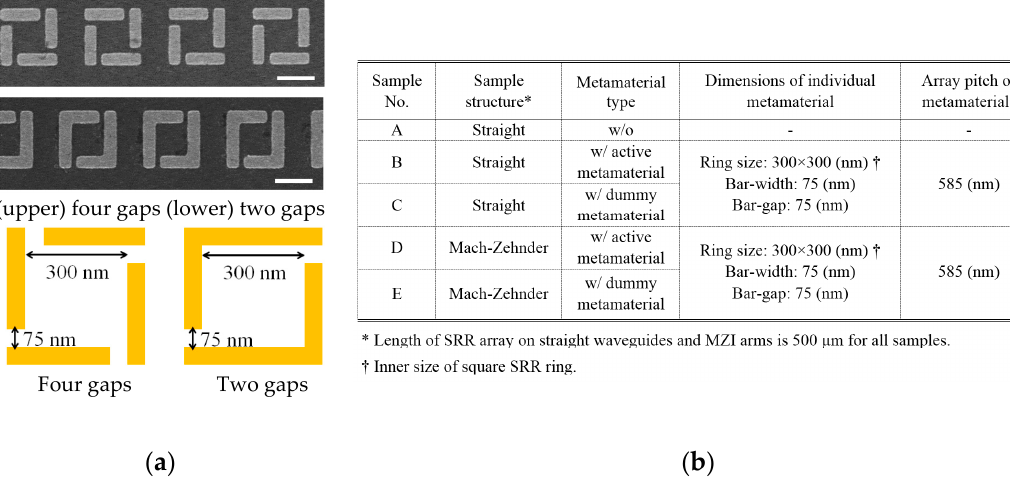
Figure 4. ( a ) Oblique view of four-gap and two-gap SRRs used for ε - μ extraction. Scanning electron microscopy (SEM) photograph and schematic view with dimensions; ( b ) All parameters used in the experiment.